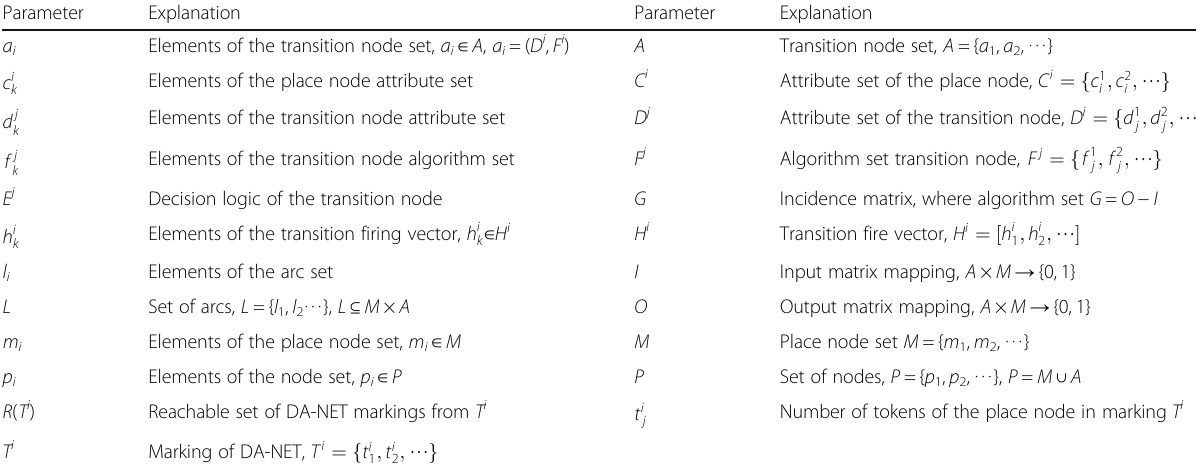
Table 1 Parameter and explanation of the DA-NET model